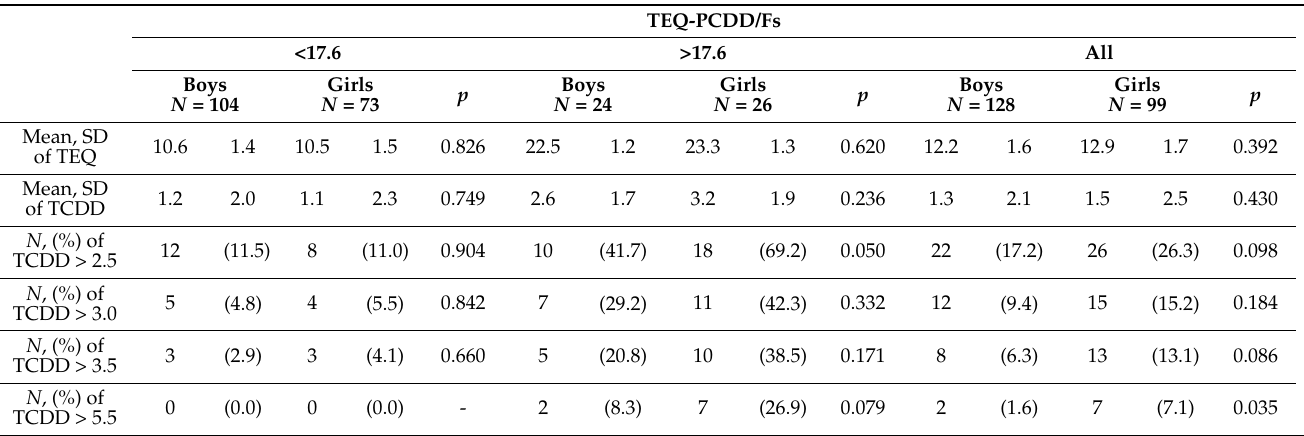
Table 3. Differences in toxin levels between sexes in children with high TCDD for each TEQ-PCDD/F